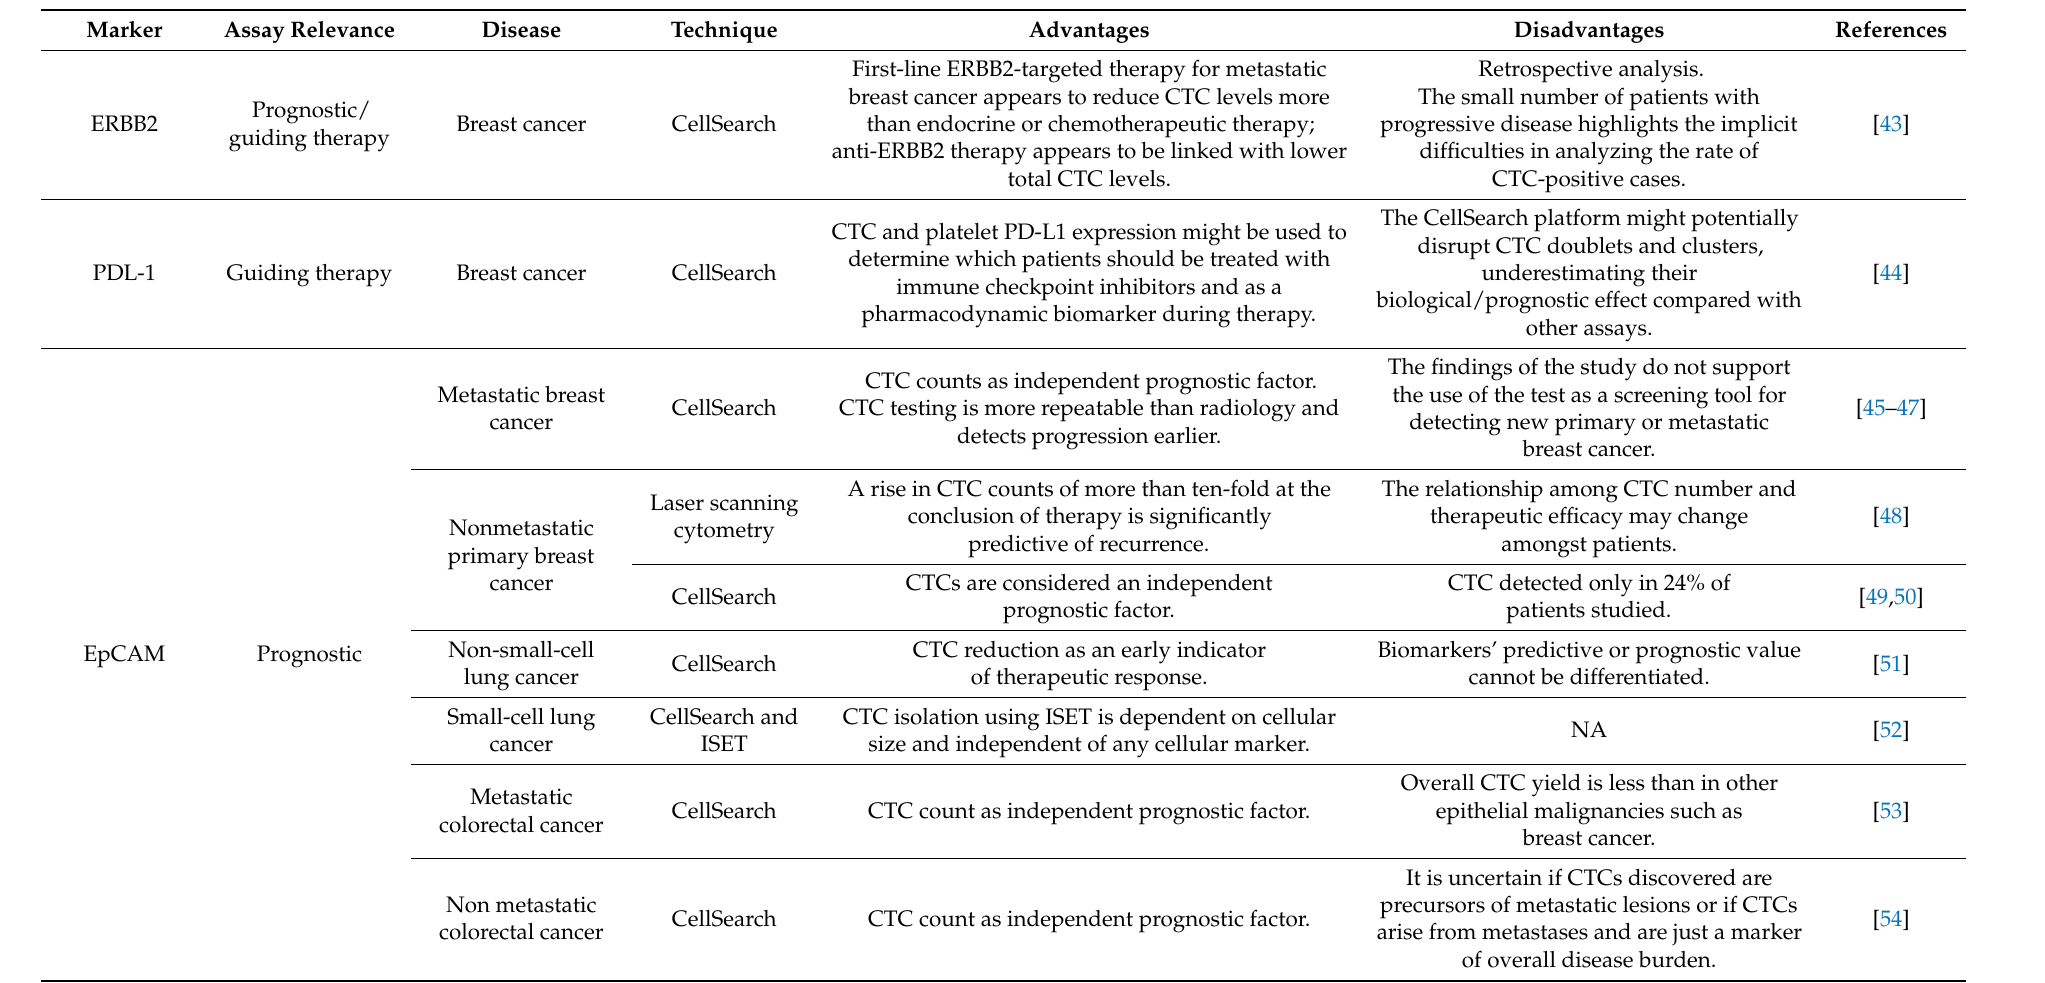
Table 1. Clinical applications of